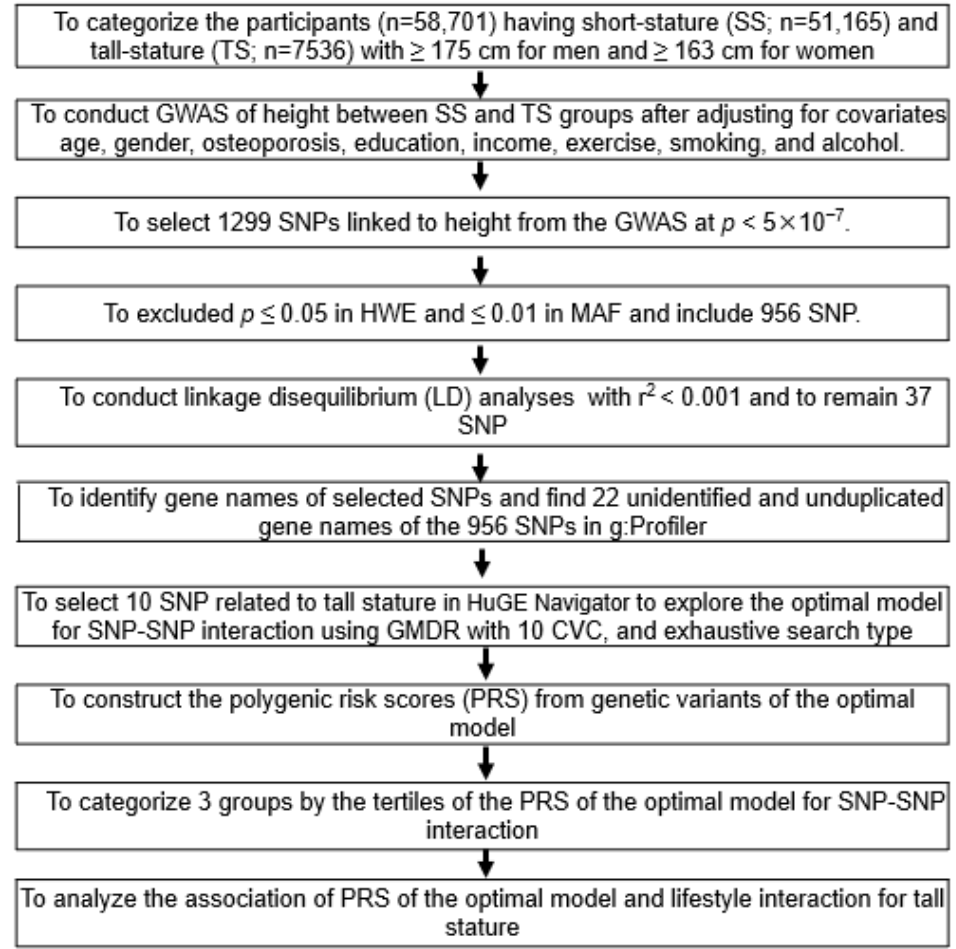
Figure 1. Flow chart to generate polygenic risk score (PRS) associated with stature by SNP–SNP interaction and its interaction with lifestyle factors. The short stature (SS; n = 51,165; control) and tall stature (TS; n = 7536; case) groups of the participants were divided by the cutoff of ≥175 cm for men and ≥163 cm for women, which were the 15th percentiles of adult height in people aged >40 years in 2010 – 2014 in Korea.